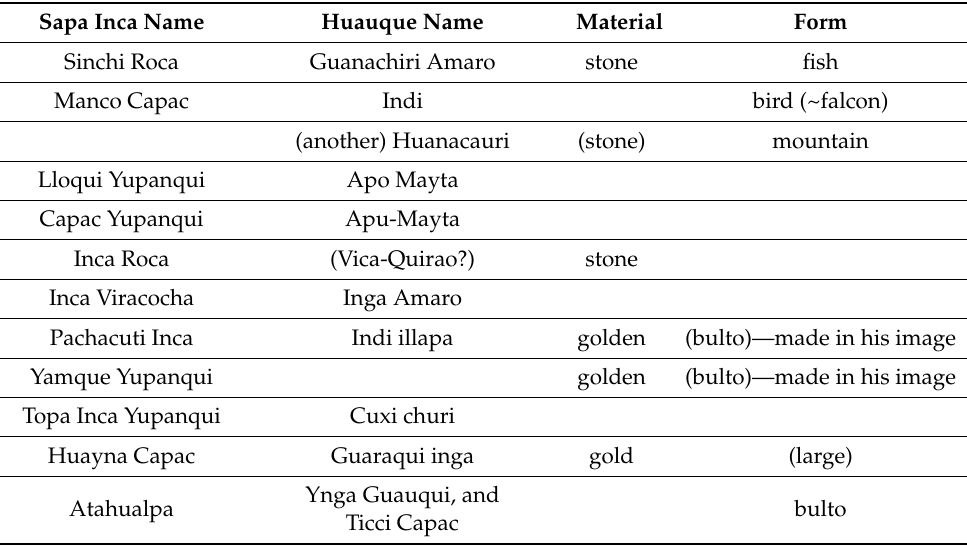
Table 3. Huauques (brother-images) of the Inca